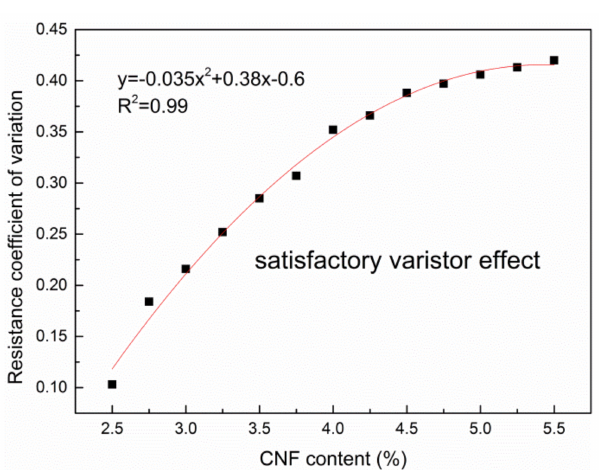
Figure 10. Relationship curve for CNF content and resistance coefficient of variation in CNFPUC